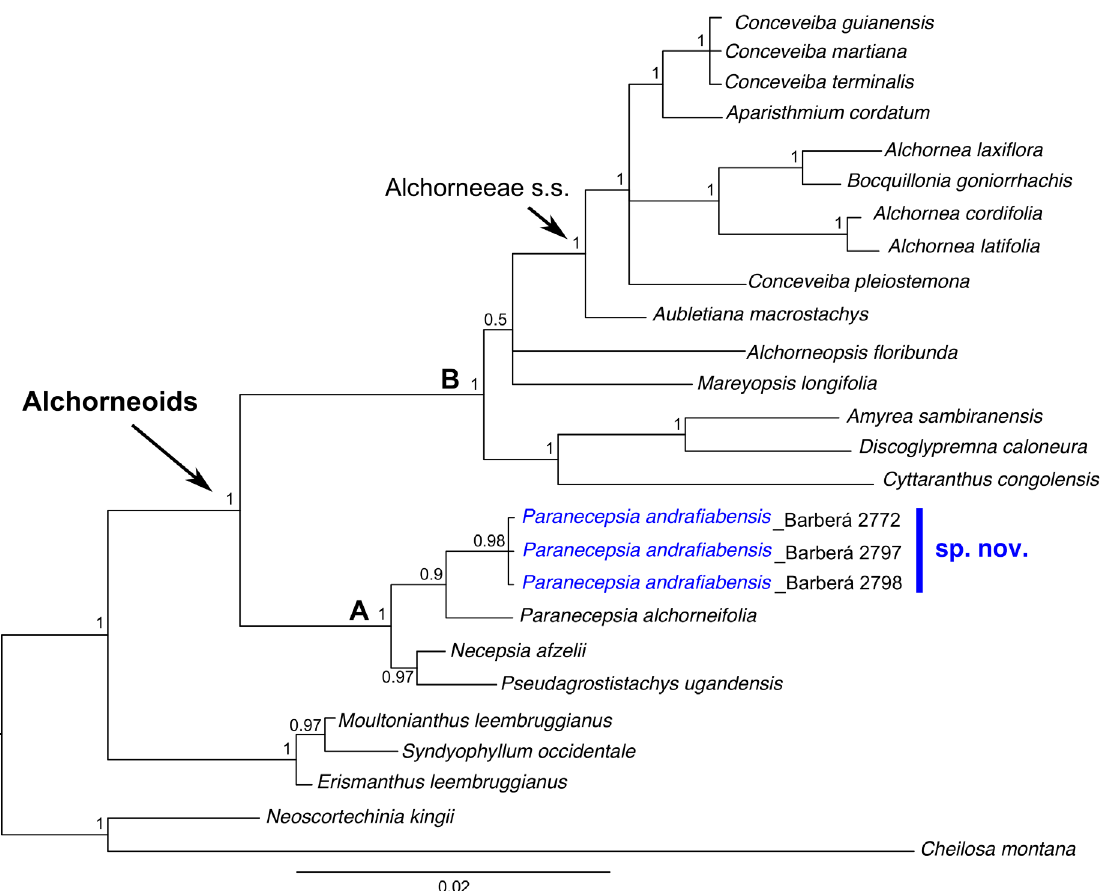
Fig. 1. Phylogenetic relationships of representatives of the alchorneoids clade within Euphorbiaceae- Acalyphoideae, including samples of the new species. Bayesian 50% majority-rule consensus tree based on the combined 2-marker, 26-tip dataset with posterior probability values indicated at nodes. Note: the name Conceveiba terminalis (Baill.) Müll.Arg. is used in place of Gavarretia terminalis Baill. in Wurdack et al .